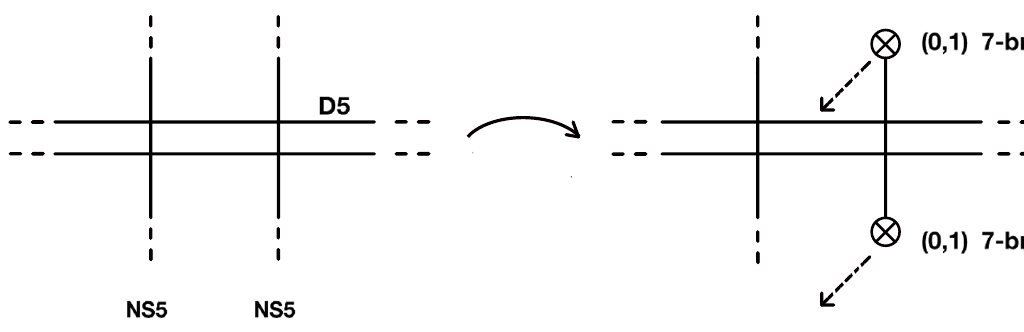
Figure 7 . SU(2) with N f = 4, moving onto a ‘baryonic